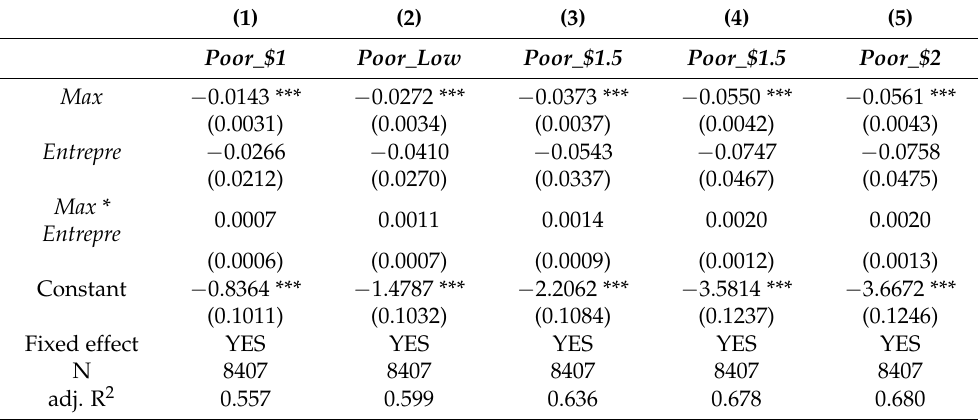
Table 16. Impact of extreme heat on poverty